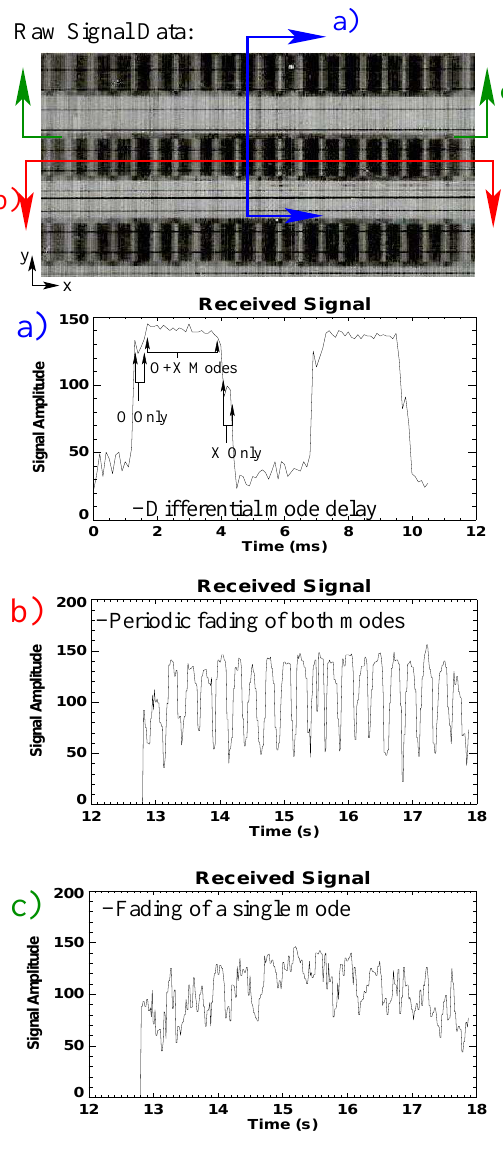
Fig. 1. A six second example of signal received by the ISIS II satel- lite at 13:59:12 UT, 3 July 1978. Dark on the grey-scale data plot at the top represents received signal amplitude on the dipole antenna. Individual amplitude scans are plotted as a function of time in the − y-direction. The grey-scale plot results from the juxtaposition of many successive amplitude scans in the + x-direction. Individual 180-Hz pulses are seen as three dark horizontal bands. This pat- tern is maintained over several seconds of time in the x-direction. Examples of: (a) Differential mode delay is observable at the be- ginning and end of each pulse. (b) Periodic Faraday fading occurs in portions of signal with both modes at a rate of 4.0Hz. (c) Single mode fades are also present. Note, the y-axis for plots (a), (b), and (c) has arbitrary relative amplitude